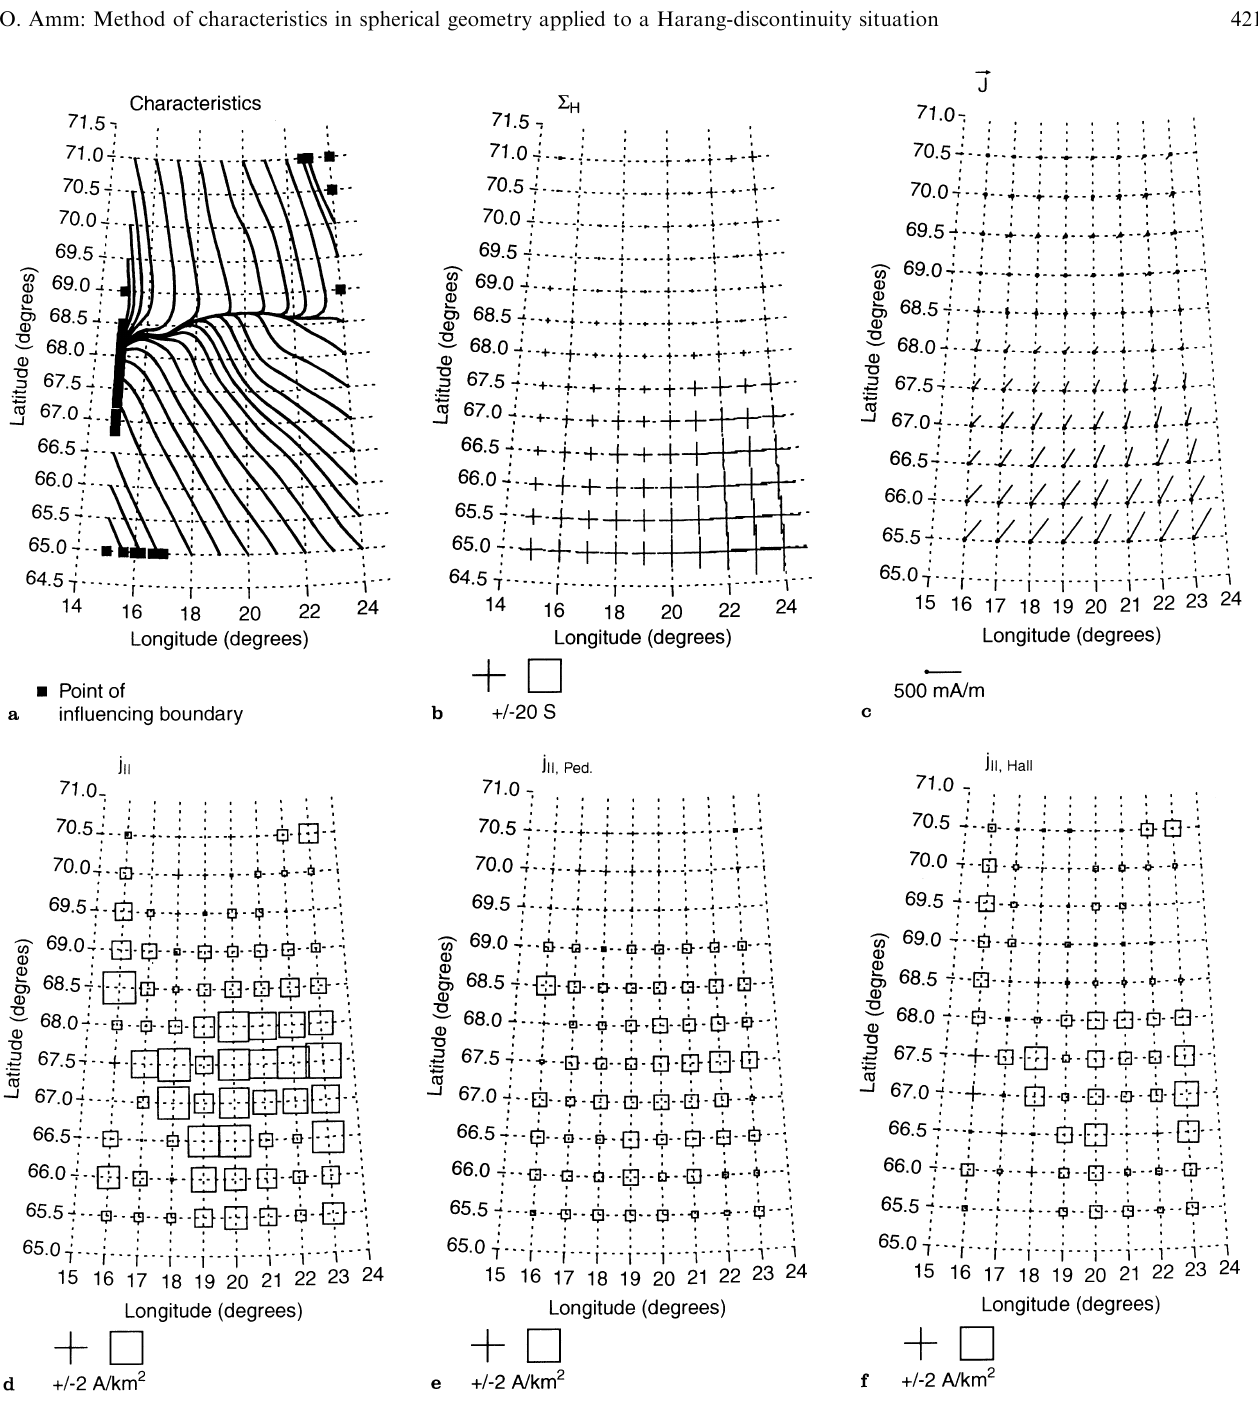
Fig. 6a–f. Results of the method of characteristics. a Characteristics; squares mark points of influencing boundary. b Hall conductance. c Ionospheric currents. d Total field- aligned currents. e Field-aligned